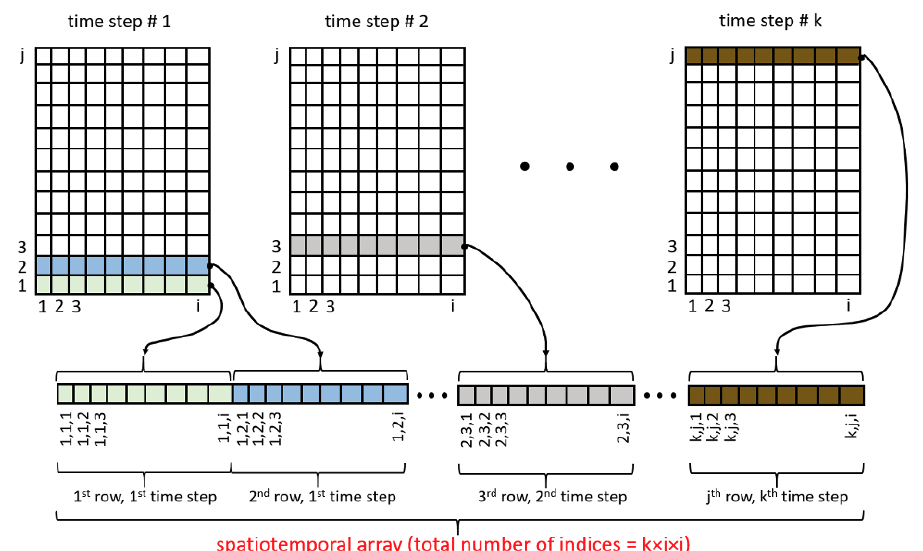
Figure 4. The concatenation process to convert the 3 dimensional input (time plus the axial and radial dimensions in space) into a spatiotemporal array. Every input variable, as well as the output variable of soot volume fraction, has its own spatiotemporal